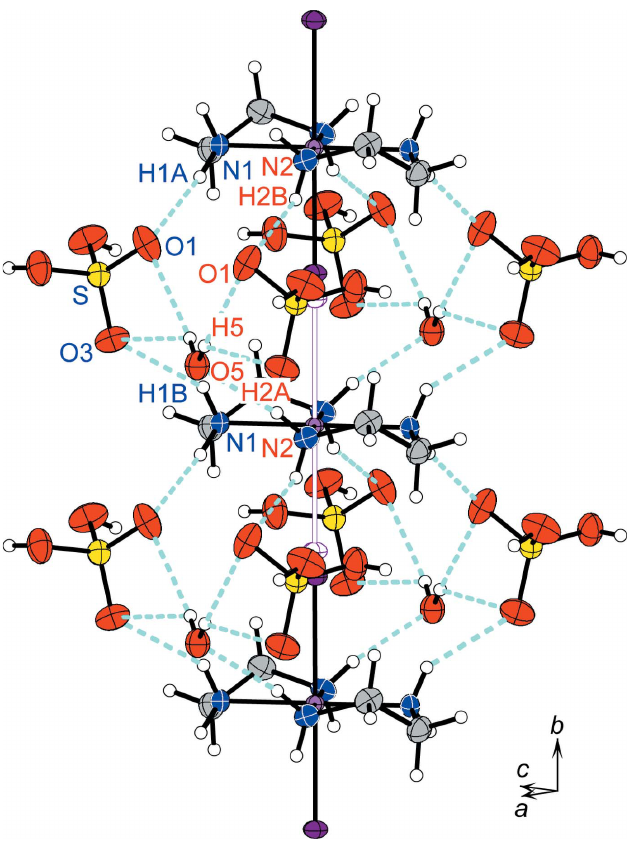
N1—H1 A (cid:2) (cid:2) (cid:2) O1 (cid:2) (cid:2) (cid:2) H2 B —N2 Pt-complex columns and hydrogen sulfate ions, and N2—H2 A (cid:2) (cid:2) (cid:2) O5 (cid:2) (cid:2) (cid:2) H2 A —N2 between the Pt-complex columns and the